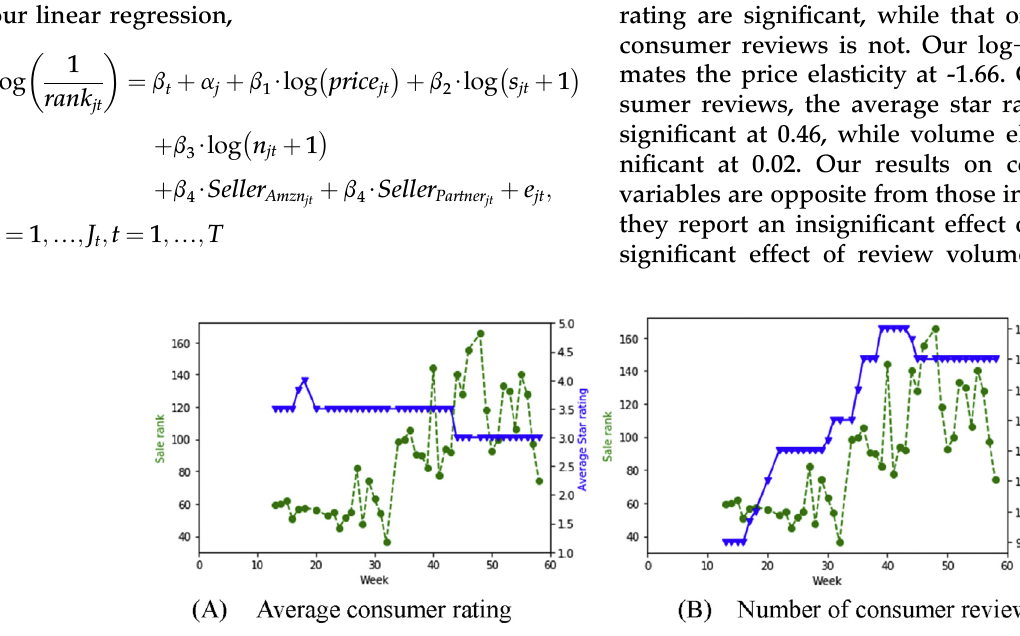
Fig. 2. Product with smaller number of reviews. Panel (A) shows the evolution of the sale rank (circle, left vertical axis) and the average consumer rating (inverted triangle, right vertical axis). Panel (B) shows the evolution of the sale rank (circle, left vertical axis) and the number of reviews (inverted triangle, right vertical